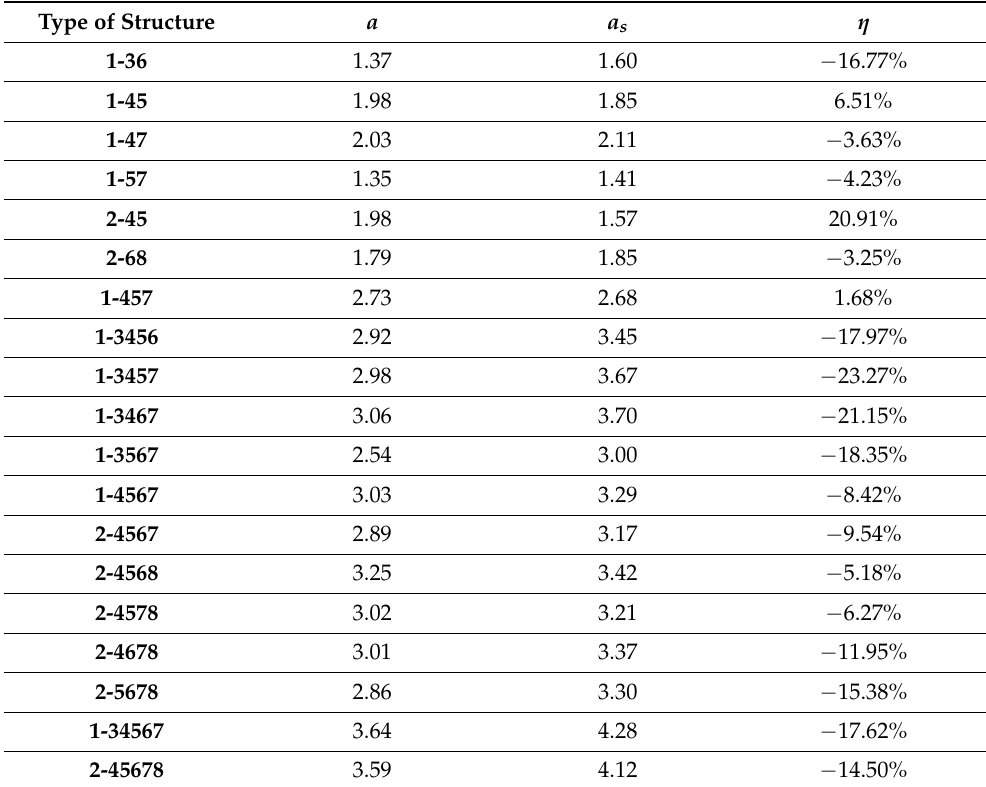
Table 4. Obtained values of the slope, a , and calculated values (assuming the perfect additivity) of a s and η (relative error of additivity) for poly(CF 3 )substituted naphthalene derivatives in dependence of its’ SESE values on SESE values of X-( m -Ph)-CF 3